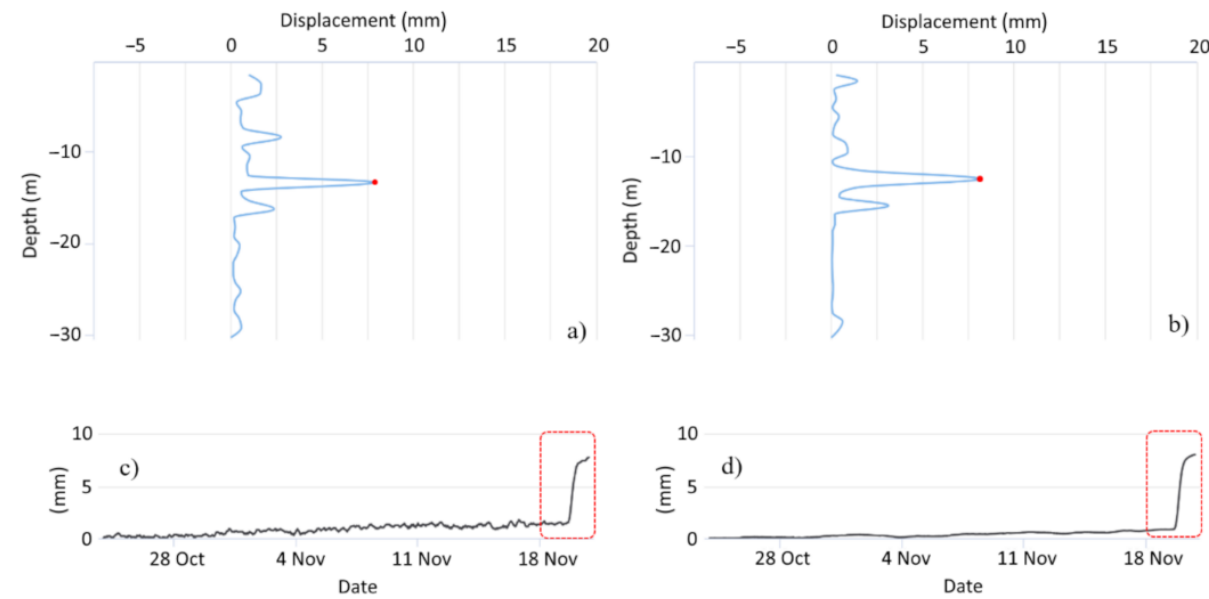
Figure 6. Comparison between local differential displacements recorded by ( a ) MEMS and ( b ) electrolytic cells along maximum grade direction and their evolution along time at a depth of 13 m ( c , d ),